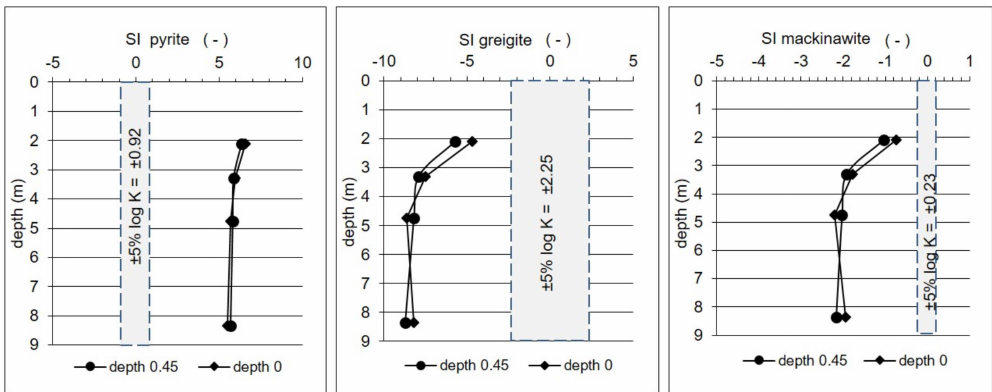
Figure 8. Saturation indices (SI) with respect to pyrite, greigite, and mackinawite. Calculations were made for chemical composition of water in two extreme positions of groundwater level, i.e., − 0.45 m bgs in November 2009, and 0.0 m bgs (i.e., the groundwater level reaches the ground surface, the peat bed is fully saturated) in April